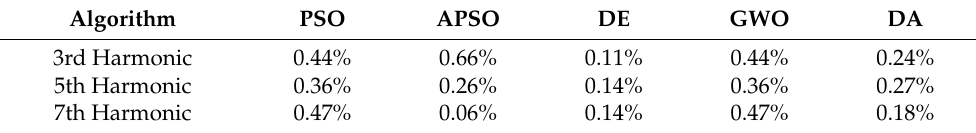
Figure 6. Summary of algorithms’ performance for a seven-level inverter. Table 3. Percentage harmonics (w.r.t. fundamental) for nine-level CHB inverter.